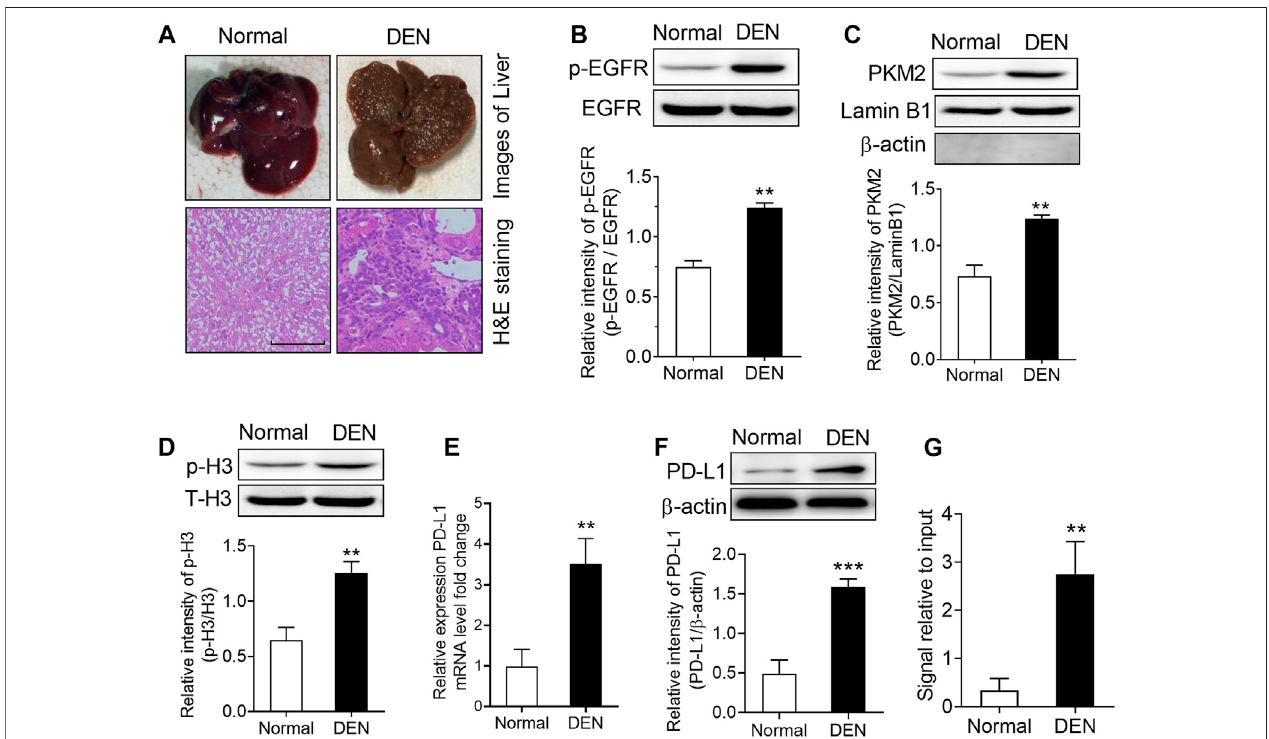
FIGURE 6 | DEN treatment induced a signi fi cant upregulation of phospho-EGFR, phospho-H3, and PKM2 nuclear accumulation in rat livers. (A) Top, representative photos of livers from normal and DEN-treated rats; bottom, representative images of H&E-stained livers. (B) The phosphorylational level of EGFR at Tyr 1068 was increased in the livers of DEN-treated rats. ** p < 0.01, two-tailed unpaired t-test, n (cid:2) 8 rats per group. (C) The expression of PKM2 nuclear protein was upregulated inthe livers ofDEN-treatedrats. Lamin B1was used asan internal control, and β -actin was used asa negative control. ** p < 0.01, two-tailed unpaired t -test, n (cid:2) 8ratspergroup. (D) ThephosphorylationallevelofH3-Thr 11 wasincreasedintheliversofDEN-treatedrats.** p < 0.01,two-tailedunpaired t -test, n (cid:2) 8ratsper group. (E,F) Theexpression ofPD-L1 mRNA (E) and protein (F) wasincreasedintheliversofDEN-treatedrats.** p < 0.01, *** p < 0.001,two-tailedunpairedt-test, n (cid:2) 8